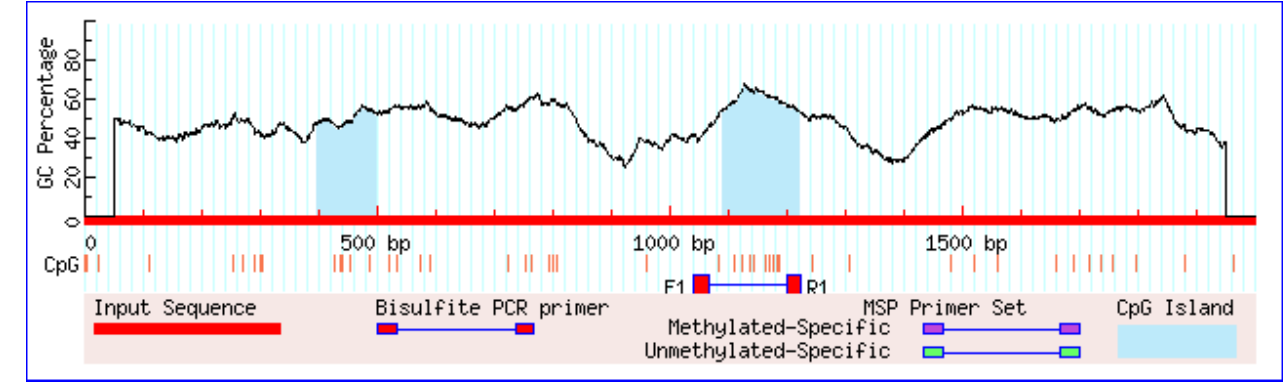
Figure 1. Bioinformatics analysis of the CpG island and primer design for bisulfite sequencing PCR of the porcine UCP3 gene. The blue region is the CpG island. CpG, cytosine-guanine dinucleotide; PCR, polymerase chain reaction; UCP3, uncoupling protein